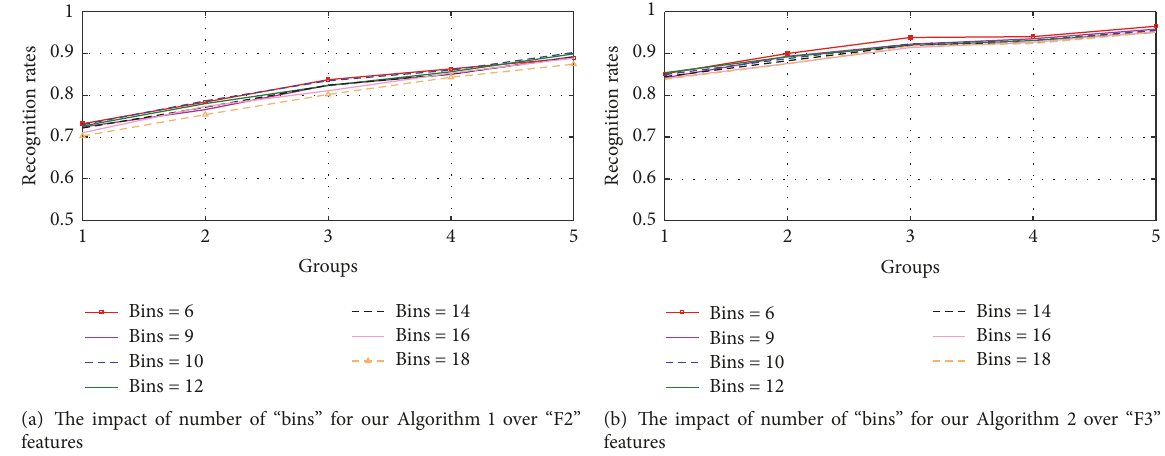
(a) The impact of number of “bins” for our Algorithm 1 over “F2” (b) The impact of number of “bins” for our Algorithm 2 over “F3” features features Figure 8: Exploring the impact of the “bins” size on our sub AR face database. Table 3: The recognition rates on subAR face database over “F1” and “F2” features; recognition rates (dimensionality).